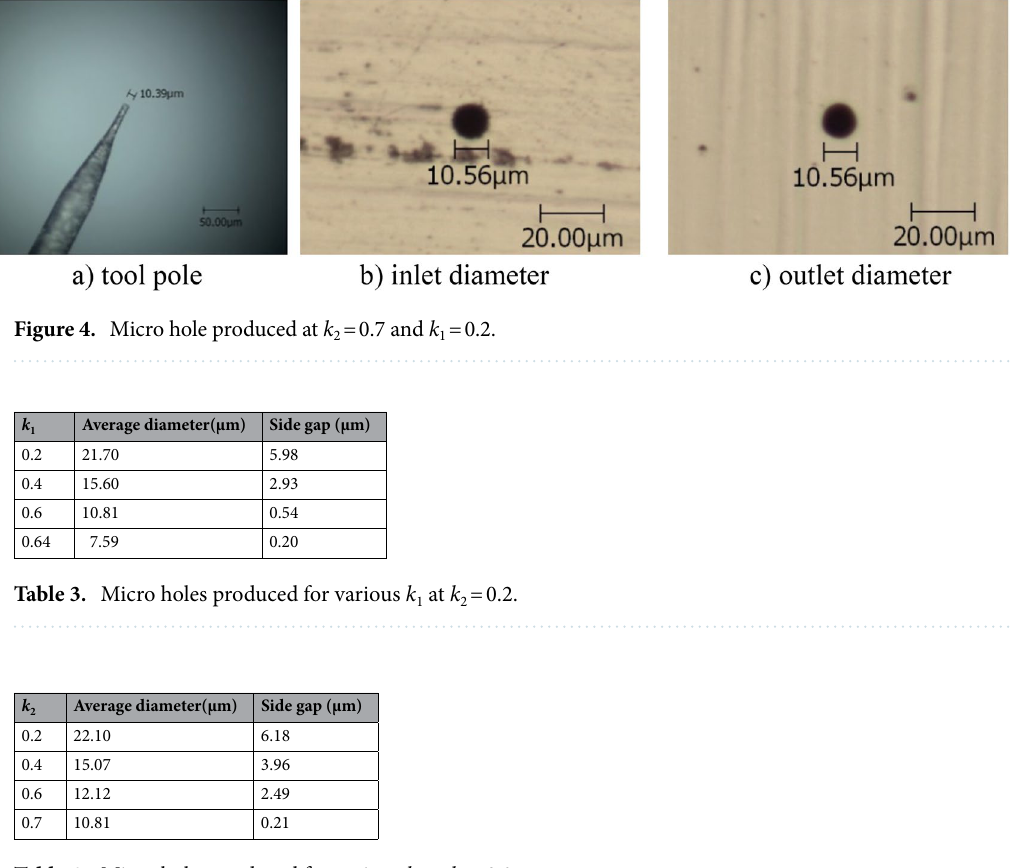
Table 4. Micro holes produced for various k 2 at k 1 =